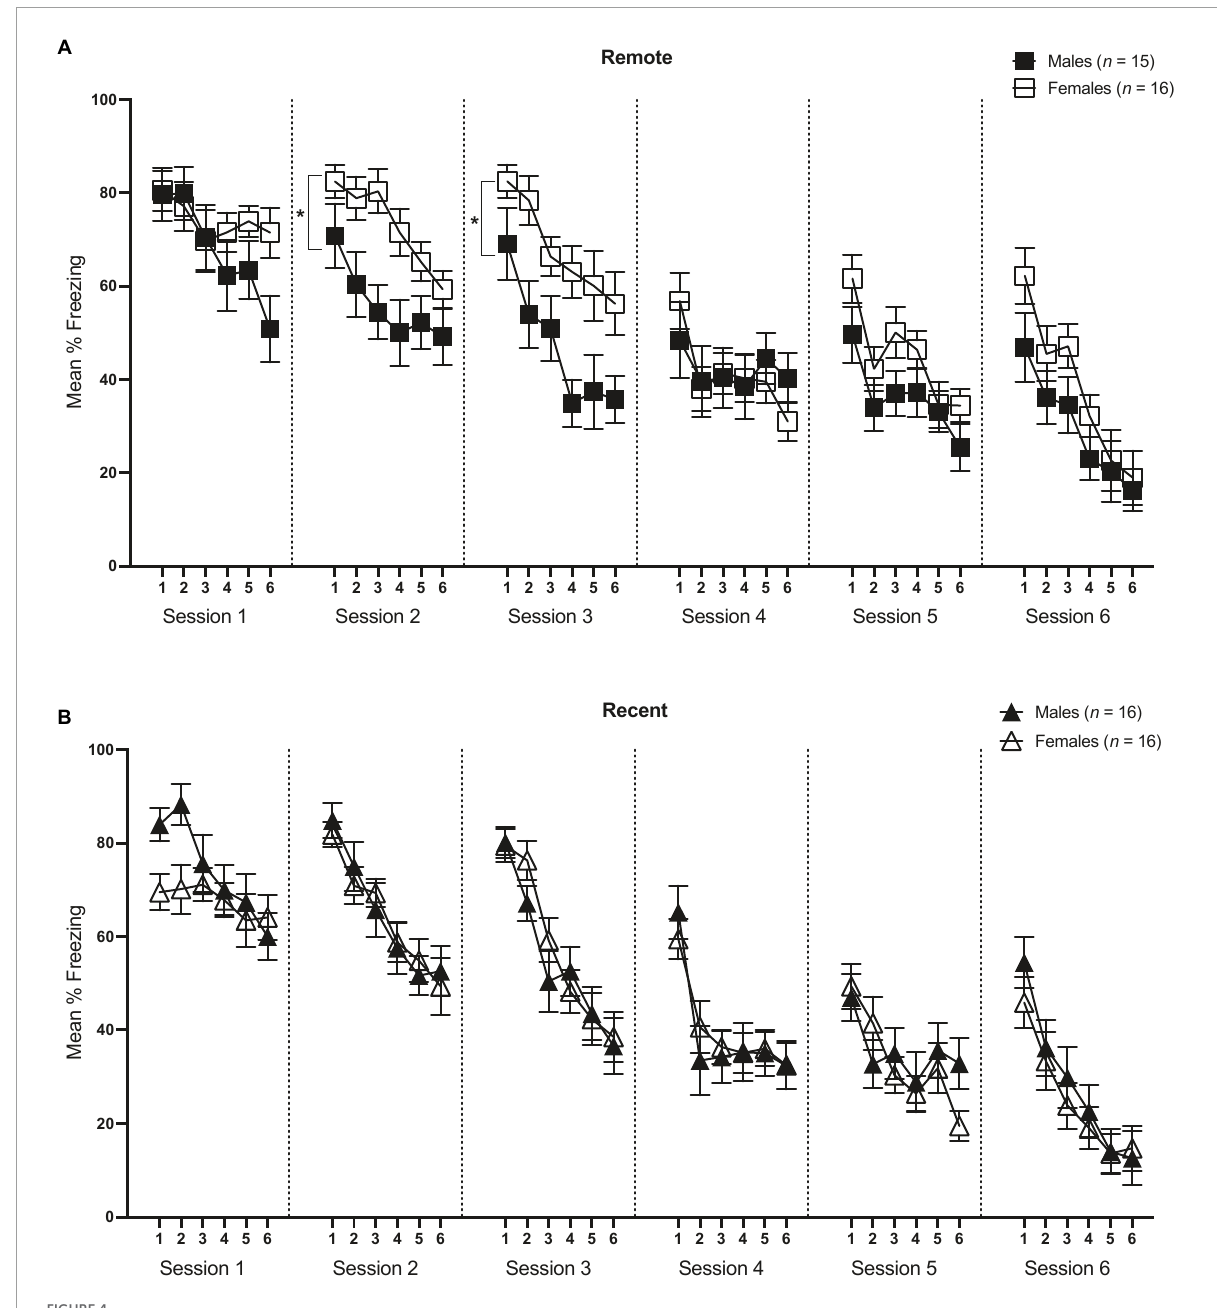
FIGURE4 Mean percent freezing ( ± SEM) during the tone retrieval/extinction tests in the Remote [upper panel (A) ] and Recent [lower panel (B) ] groups across blocks of 5 trials during each session. *Indicates significant with p < 0.05.